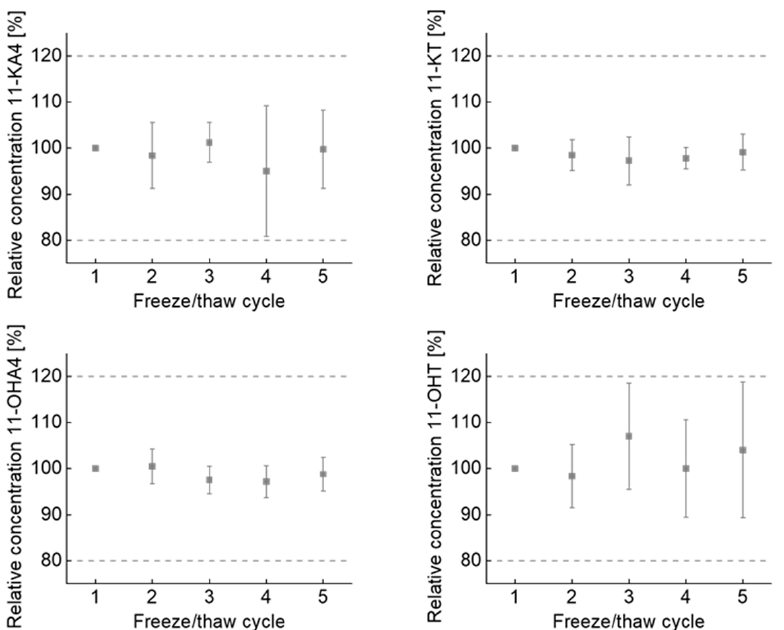
Figure 3. 11-OAs are stable across repeated freeze/thaw cycles. Dot plots show mean and coefficient of variation of 5 individually sample preparations. Data are presented relative to the concentration of first freeze/thaw cycle. Analyte ranges were from 3.1 nmol/L to 8.1 nmol/L for 11-OHA4, 0.3 nmol/L to 0.8 nmol/L for 11-KA4, 0.3 nmol/L to 1.2 nmol/L for 11-OHT and 0.6 nmol/L to 2.6 nmol/L for 11-KT. Error bars represent standard derivations, dashed lines indicate the acceptable limit of change ( ± 20%). 11-KA4, 11-ketoandrostenedione; 11-KT, 11-ketotestosterone; 11-OHA4, 11 β -hydroxyandrostenedione; 11-OHT, 11 β -hydroxytestosterone;.